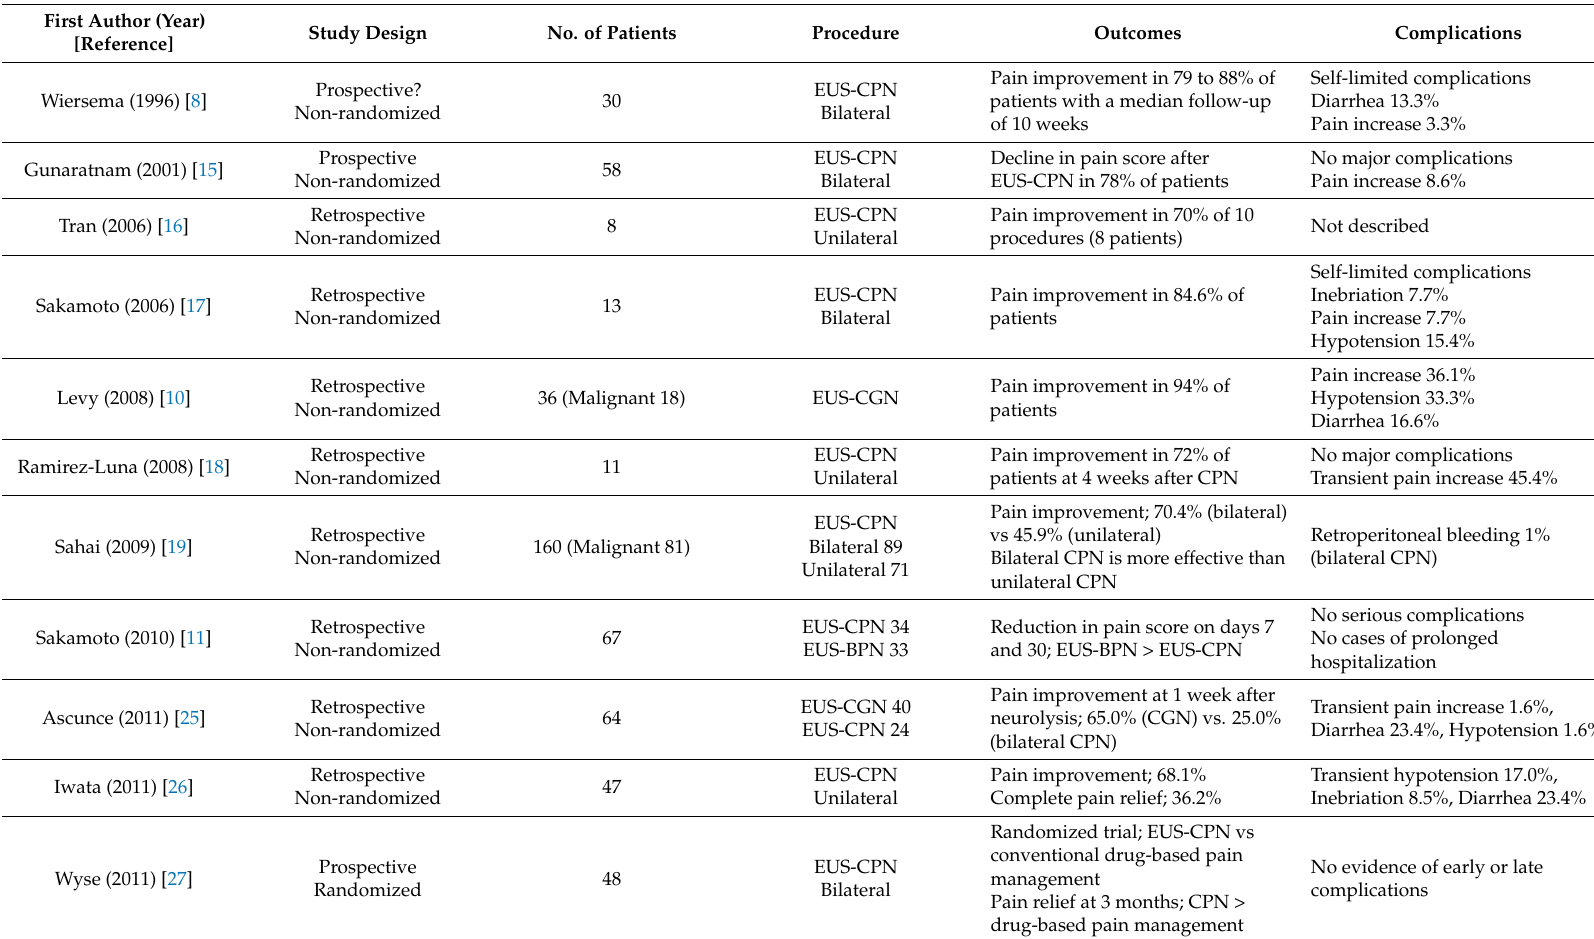
Table 1. Clinical studies of efficacy and safety of endoscopic ultrasound (EUS)-guided